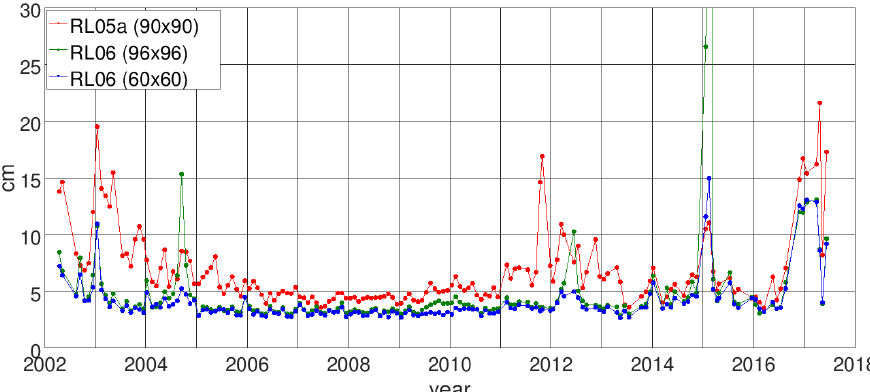
Figure 6. wRMS over the oceans (cm EWH) of DDK5 filtered residuals relative to a climatology model for the complete GFZ RL05a (red), GFZ RL06 (96 × 96, green), and GFZ RL06 (60 × 60, blue) time